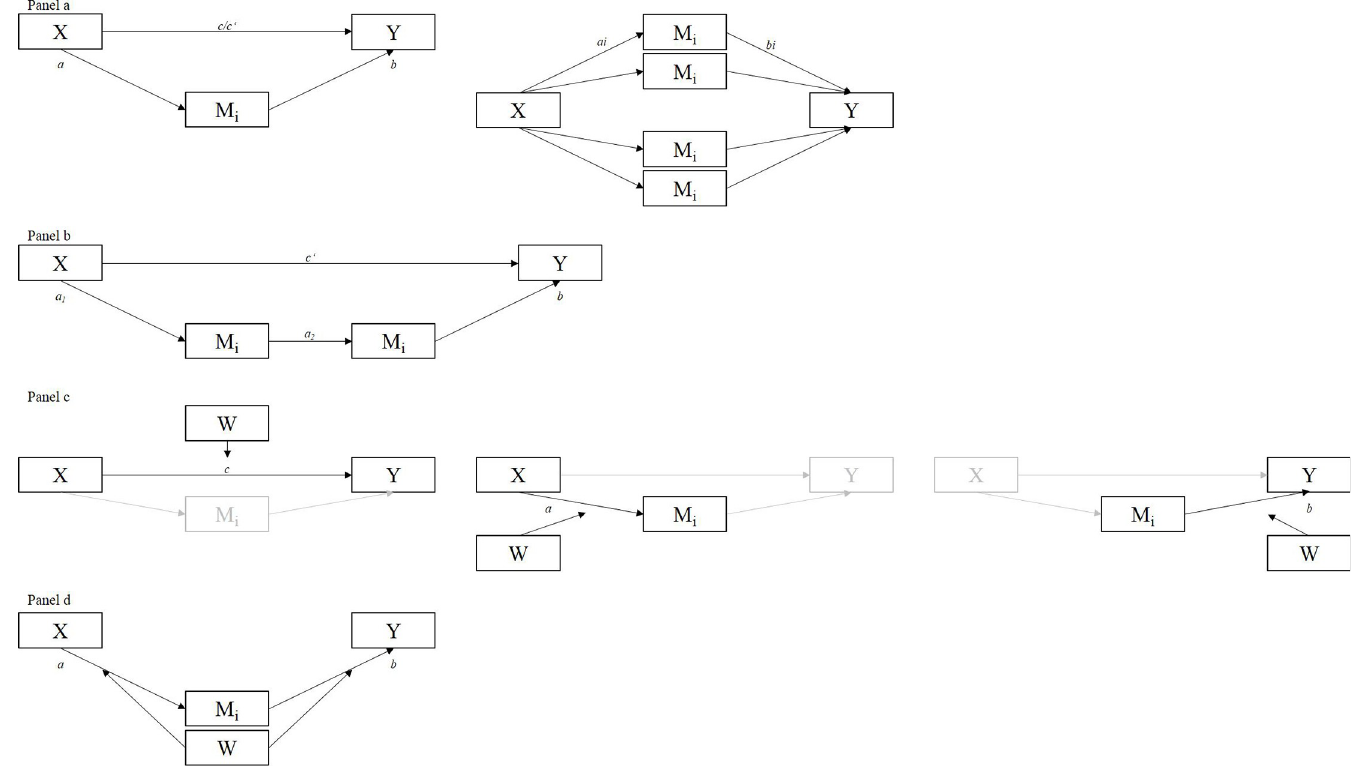
Fig 1. Conceptual diagrams of the specified models. Panel a : Simple and parallel multiple mediator models specifying tinnitus-related distress as independent, the putative mediators’ total (left) or subscale scores (right) as mediating, and affective or sensory pain perception as dependent variables. Panel b : Serial multiple mediator models specifying tinnitus-related distress as independent, psychological ‘comorbidities’ as first-level mediating variables, psychological process variables (depressivity, perceived stress, and coping attitudes) as second-level mediating variables, and affective or sensory pain perception as dependent variables. Panel c : Simple moderator models investigating the effect of tinnitus decompensation vs. compensation (W) on paths c (left), a (middle), or b (right). Panel d : Moderated mediation model investigating the effect of tinnitus decompensation vs. compensation on ab .